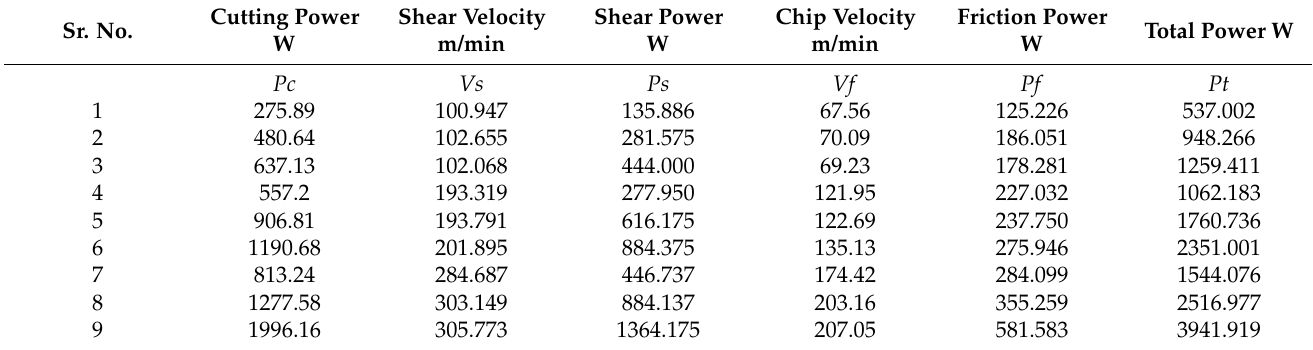
Table 7. Cutting power, shear power, friction power and total power at different cutting conditions. Sr.